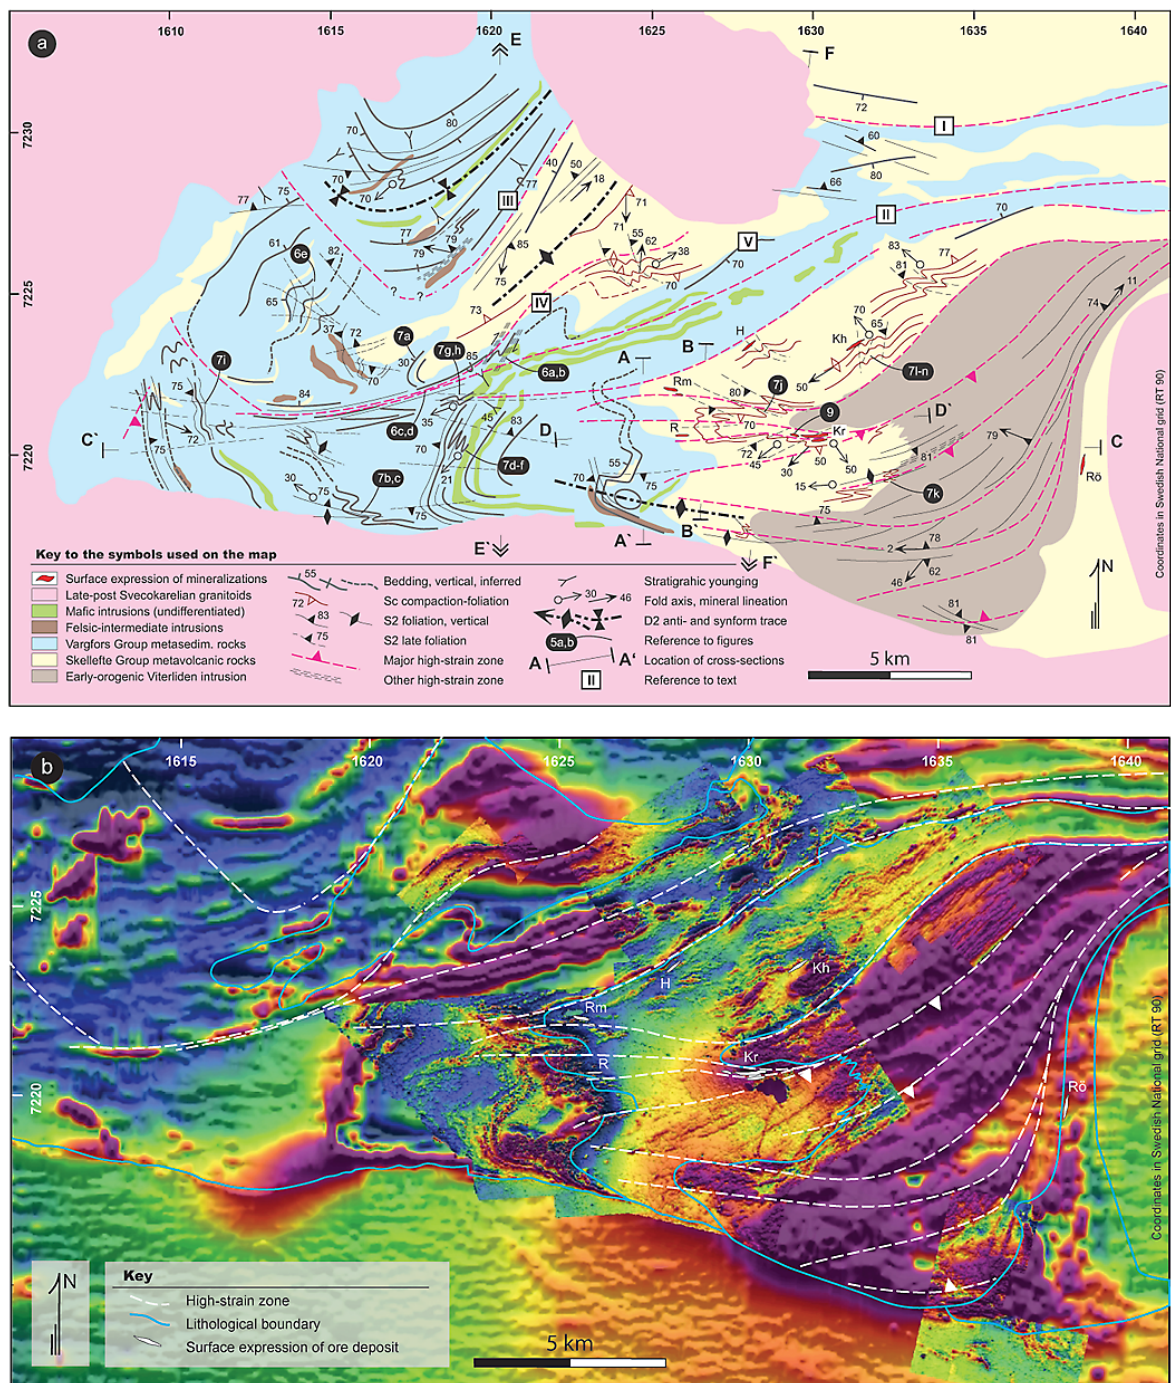
Fig. 2. (a) Kristineberg area geology. Modified after Kathol et al. (2005) and Skyttä et al. (2009, 2010), with new structural data from 249 localities visited during the course of the work. The “Northern and Southern antiforms” cited in the text are located to the north and south of the high-strain zone “II”. “Hi-Res” and “Profile 2” in Fig. 4c and d (Dehghannejad et al., 2010) are located along cross sections B–B‘ and D–D‘, respectively. E–E‘ and F–F‘ indicate the locations for “Profile 5” and “Profile 1” in Fig. 4a and b (Tryggvason et al., 2006); notice that “Profiles 1 and 5” extend beyond the area of this figure. Geological cross sections A–A’, B–B’ and C–C’ are shown in Fig. 5. Ore deposits: H: Hornträskviken, Kh: Kimheden, Kr: Kristineberg, R: Rävliden, Rm: Rävlidmyran, Rö: Rökå. (b) Total magnetic map of the Kriberg area (aeromagnetic covering the whole figure, source SGU; ground magnetic map for the central parts, source Boliden Mineral AB). Notice that the extent of (b) is smaller than that of (a)